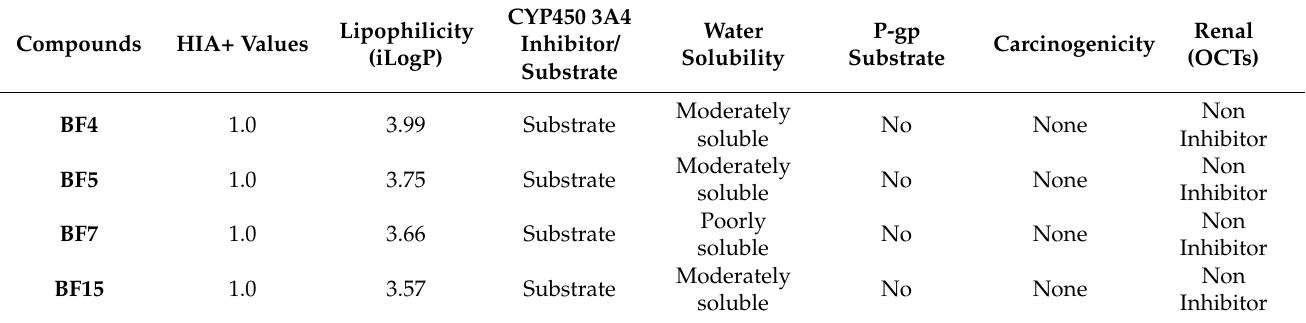
Table 2. ADMET profile of BF4 , BF5 , BF7 and BF15 furan-1,3,4-oxadiazole compounds.